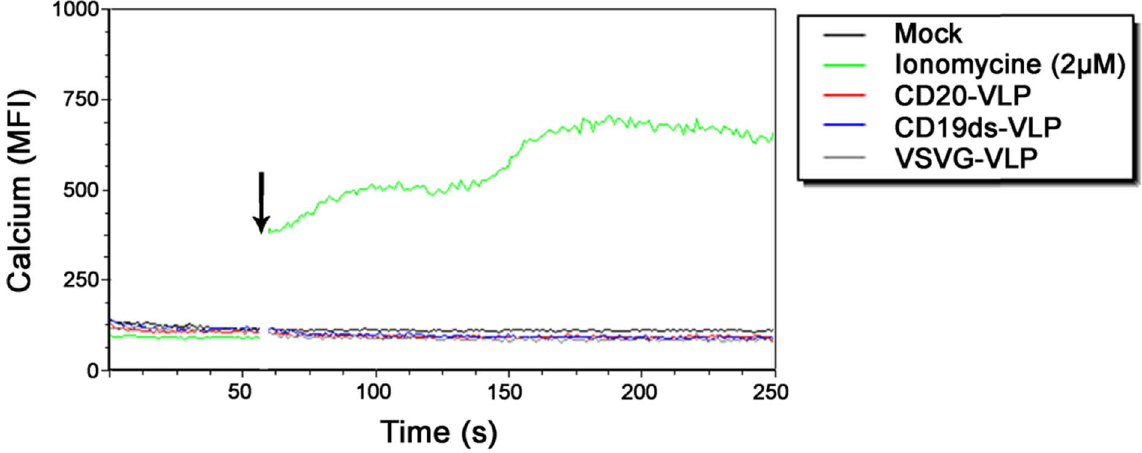
Figure 5. CD20-VLP and CD19ds-VLP do not induce calcium influx into unstimulated primary human B lymphocytes. Freshly isolated primary human B lymphocytes were labeled with Calcium Sensor Dye eFluor H 514 and labeled cells were assessed by flow cytometry to establish a baseline level of fluorescence. Then cells were removed, incubated with the indicated stimulants, and replaced immediately for further flow cytometric analysis. The transient increase in intracellular calcium concentration was recorded by monitoring the change in MFI of the cells. To determine the background auto-fluorescence of the cells, one sample was recorded without the addition of any stimulant after baseline monitoring (mock). The gap in the histogram reflects the time-period when the tube containing the cells was removed from the instrument to add the stimulants. The arrow indicates the time-point of addition of the stimulant. VLP: virus like particles; MFI: mean fluorescence intensity.